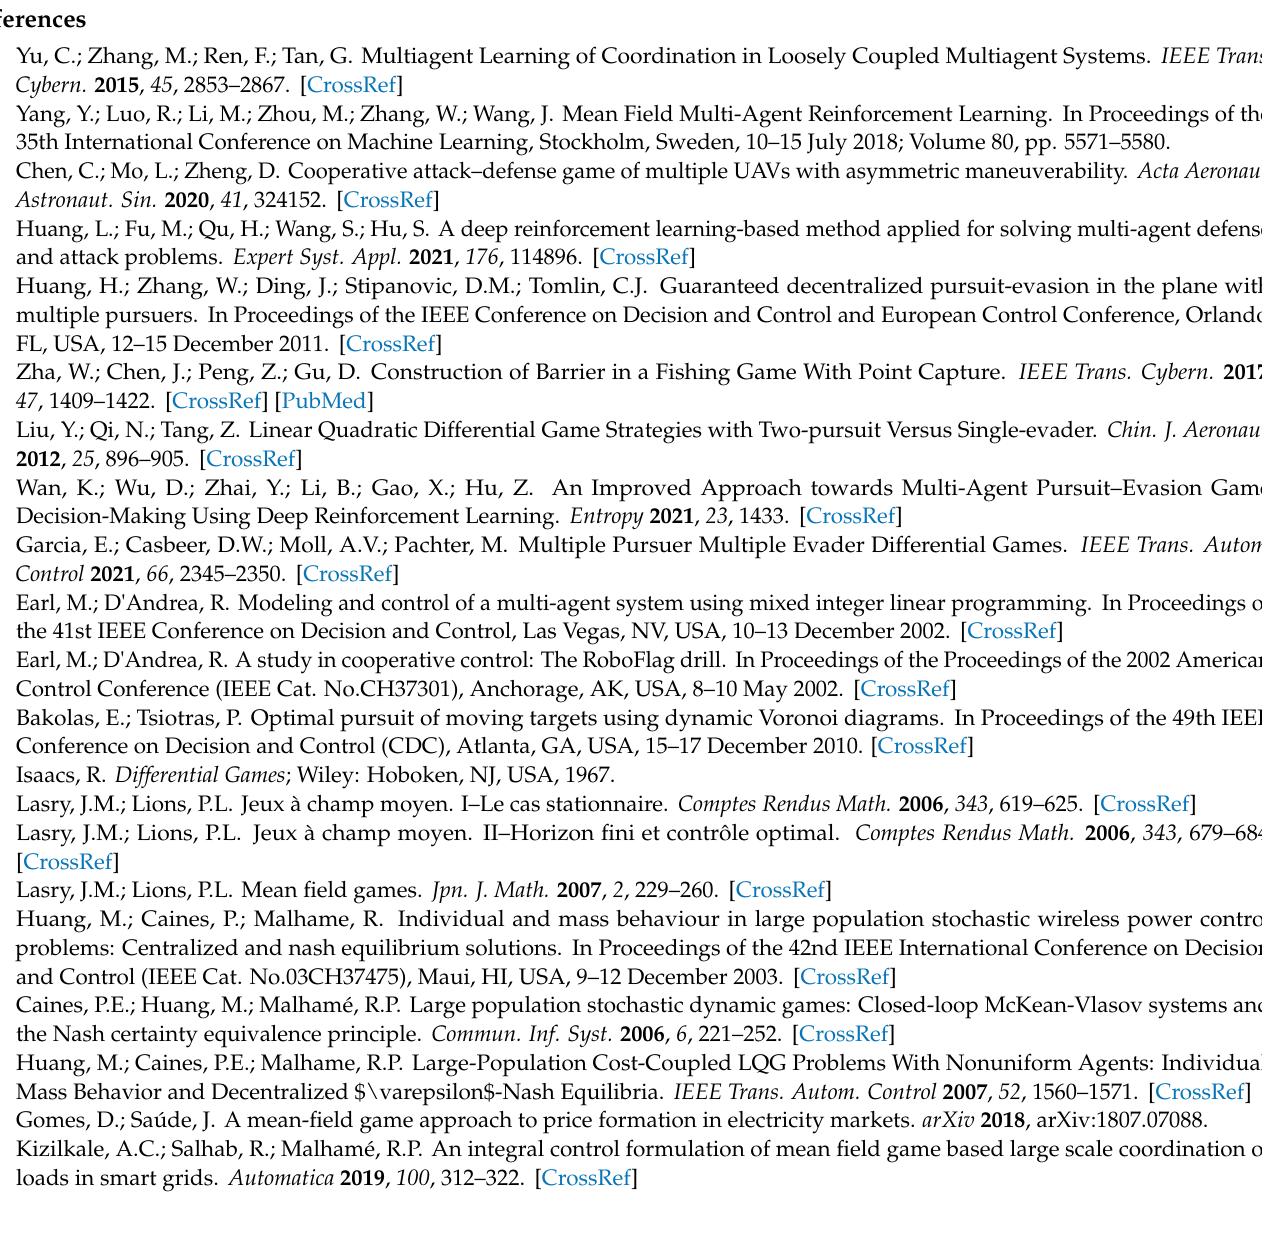
Figure A3. The 3D run diagram of the asymmetric case about large-scale UAV attack and defense behaviors under ν = 0.08, e r = 1.1. ( a ) Blue side vs. red side: 100 vs. 60; ( b ) Blue side vs. red side: 60 vs.